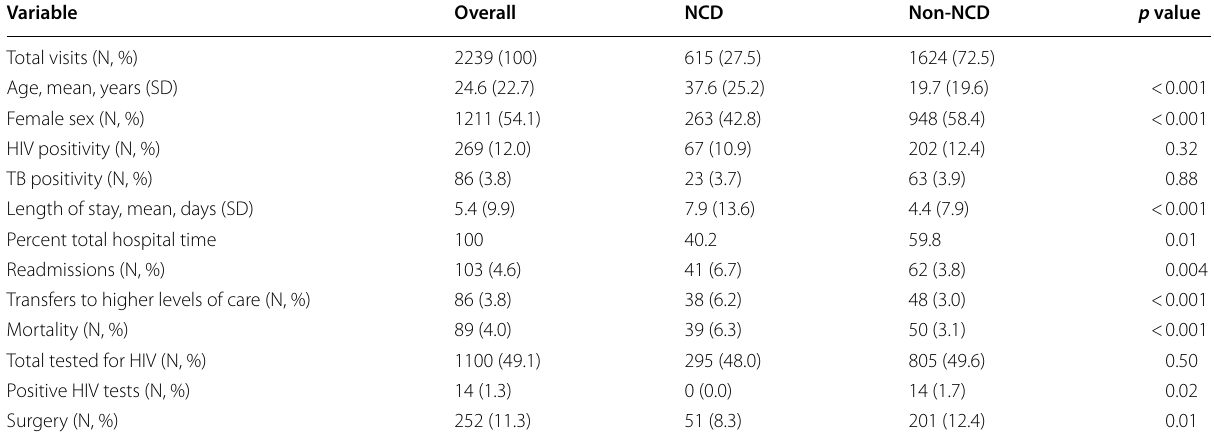
Table 1 Baseline